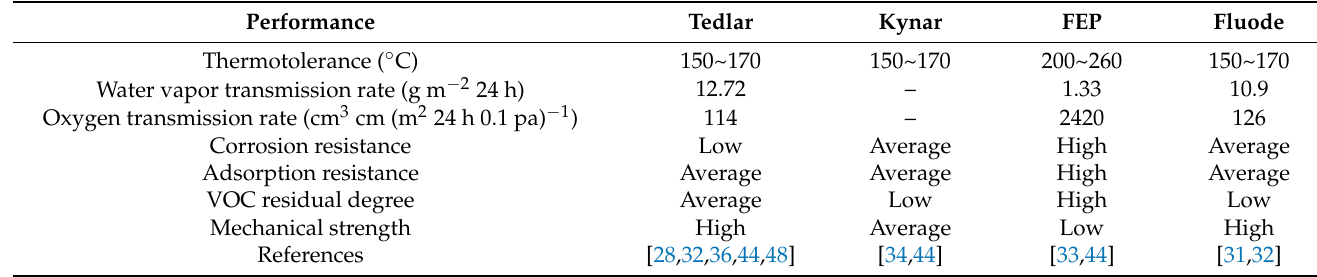
Table 2. Performance comparison of commonly used fluoropolymer film sampling bags. Performance Tedlar Kynar FEP Fluode Thermotolerance ( ◦ C)